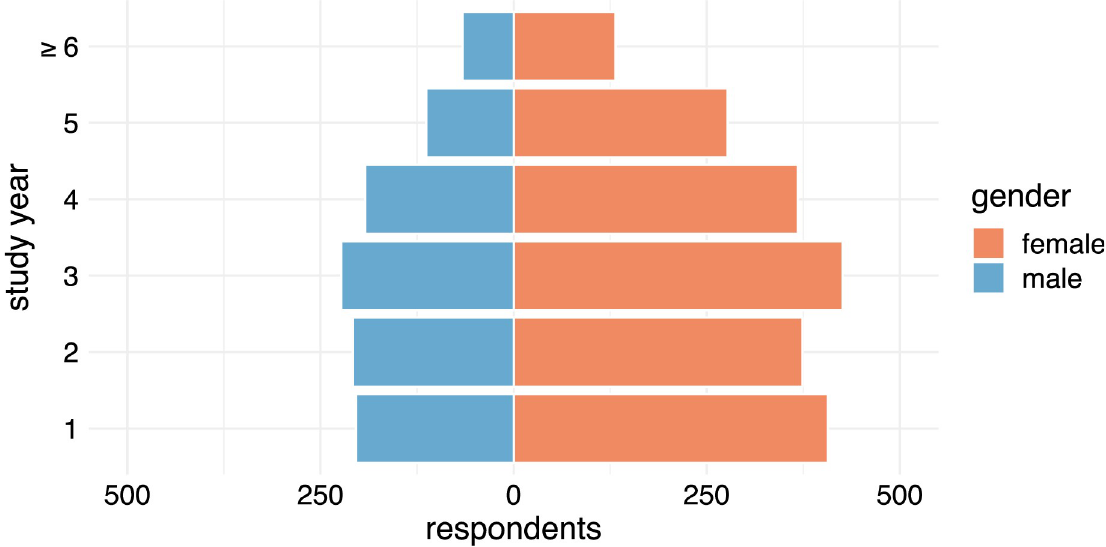
Fig 1. Distribution of the participants according to sex and to their current study year. A total of 29 participants are not included in this figure due to: non-binary gender (n = 16), missing gender (n = 9), and missing study year (n = 4).